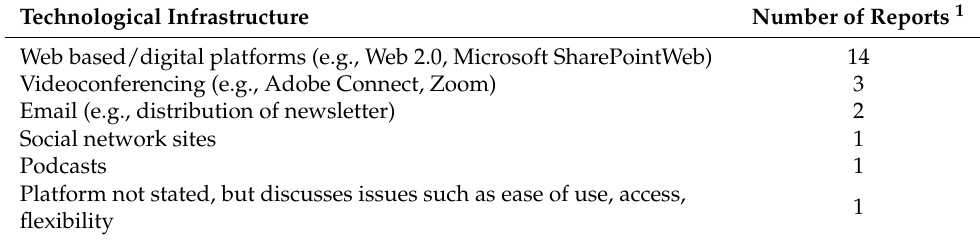
Table 3. Technological infrastructure of